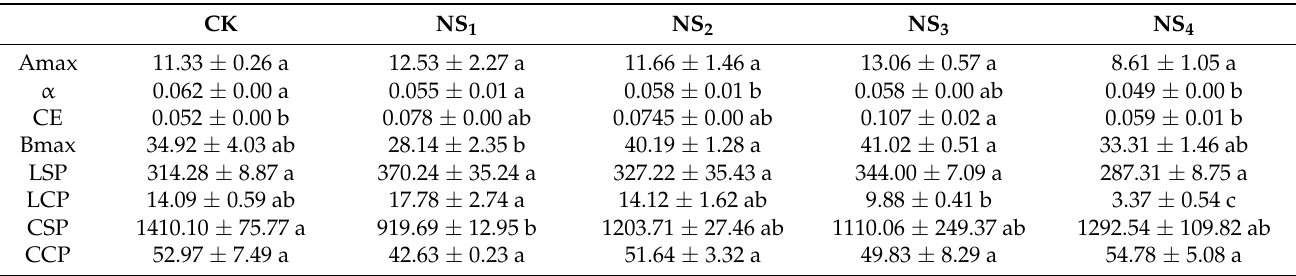
Table 1. Photosynthetic parameters under different concentrations of NaHSO 3